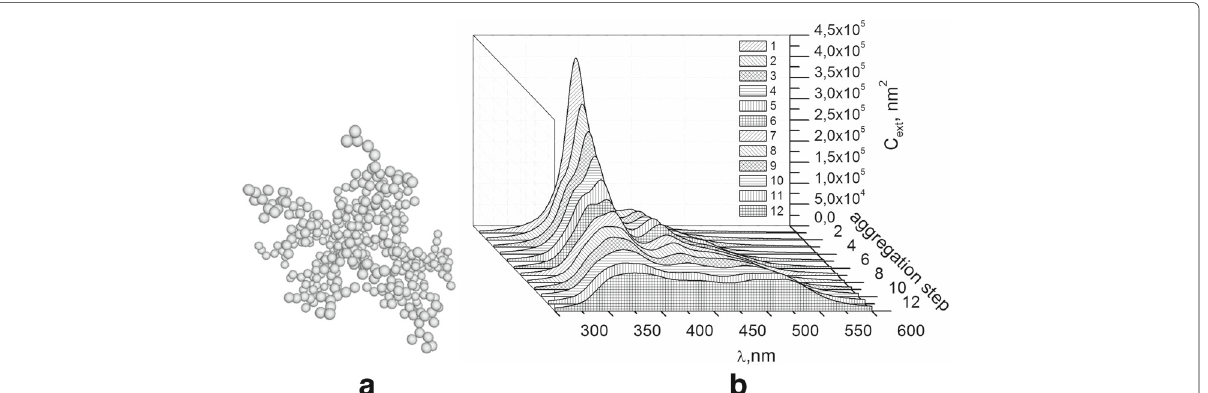
Fig. 5 a The fractal cluster simulated within the model of “cluster-cluster.” b Extinction spectra of the nanoparticles at different stages (curves 1–12) of fractal cluster formation